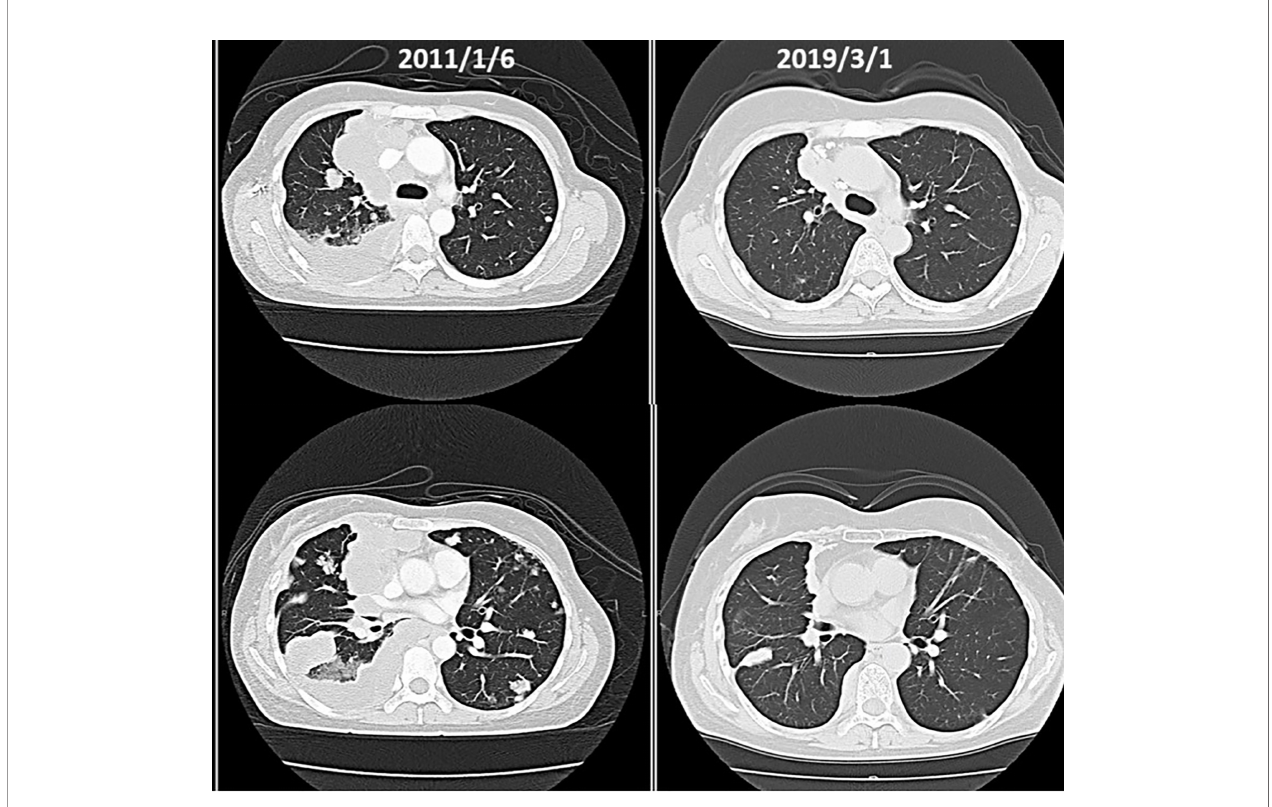
FIGURE 13 | CT scans reveals gradual shrinkage of the tumors.